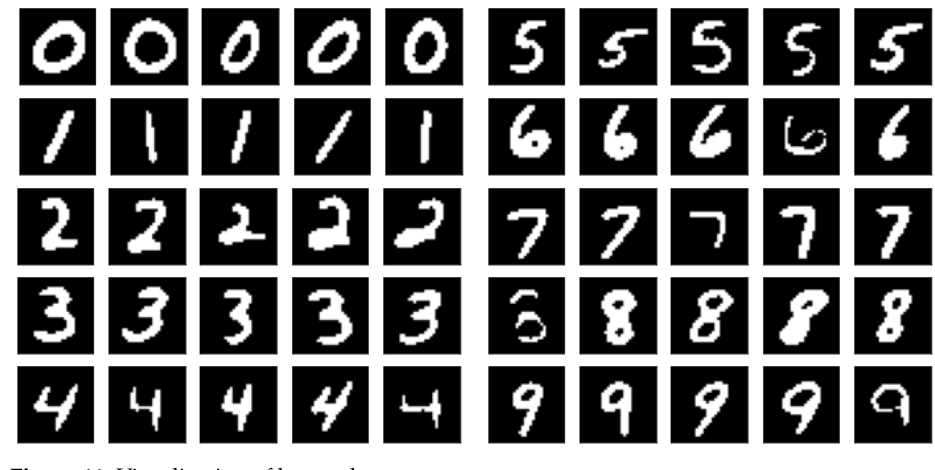
Figure 11. Visualization of hyperplanes.